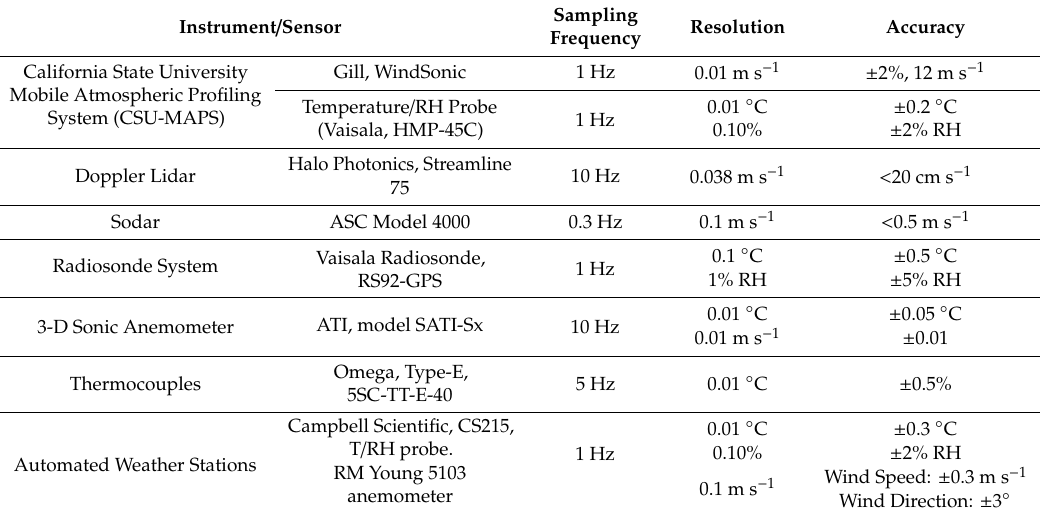
Table 1. Sensor and instrument